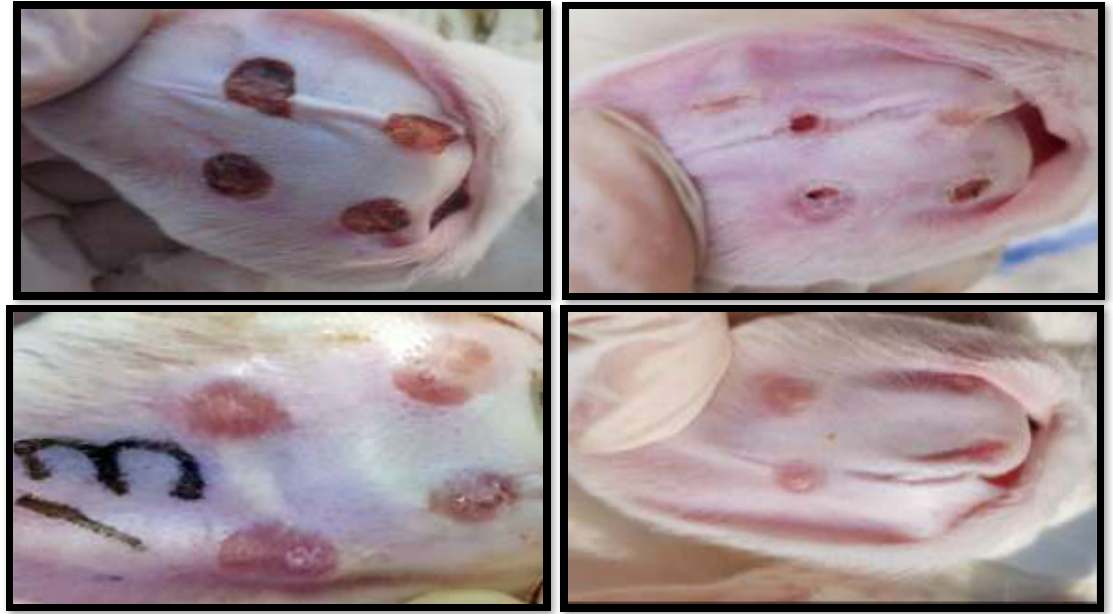
Figure 1. Gross morphological features of healing rate in the induced hypertrophic scar of rabbits during